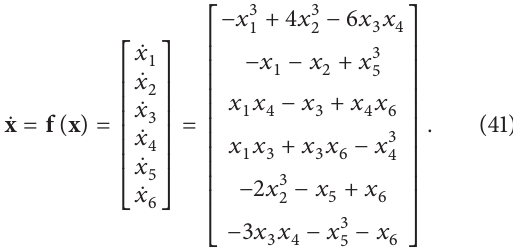
Algorithm 9. Verified Parametric Optimization